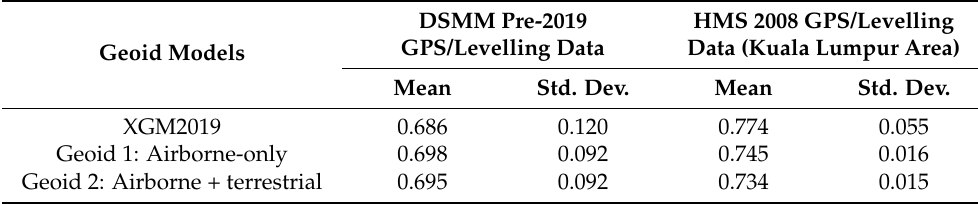
Table 10. Fit of older GPS/levelling data to the airborne-only geoid and combined geoid (in meters). DSMM Pre-2019 GPS/Levelling Data Geoid Models